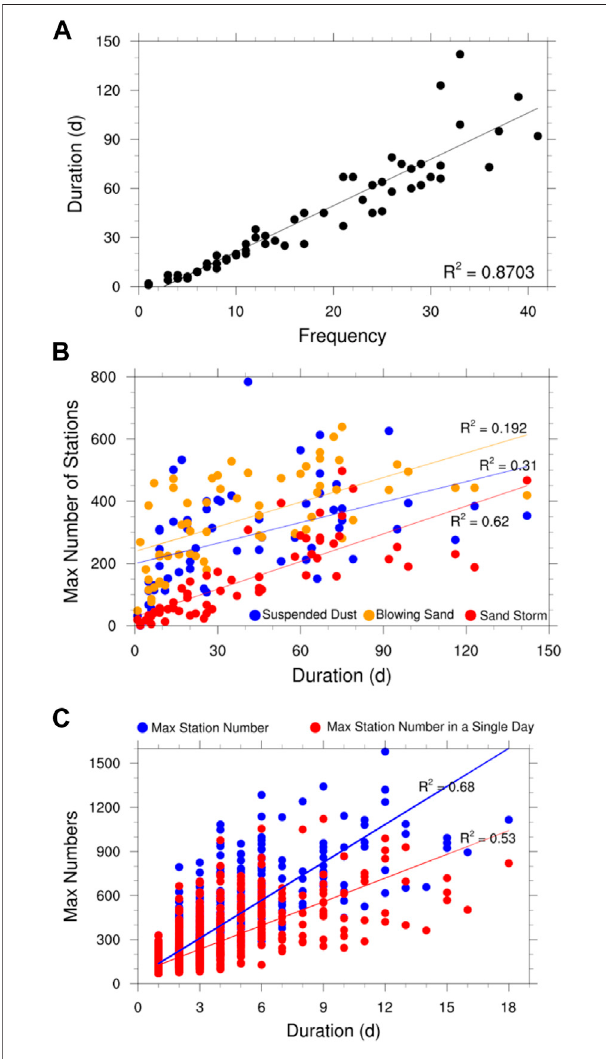
FIGURE13| Scatterplotsofallthesand-dustprocessesin1961 – 2020. (A) Annual frequency and annual total duration. (B) Annual total duration and themaximumnumberofaffectedstationsfordifferentcategoriesofsand-dust processes. (C) maximum duration, maximum numbers of affected stations in a single process and a single